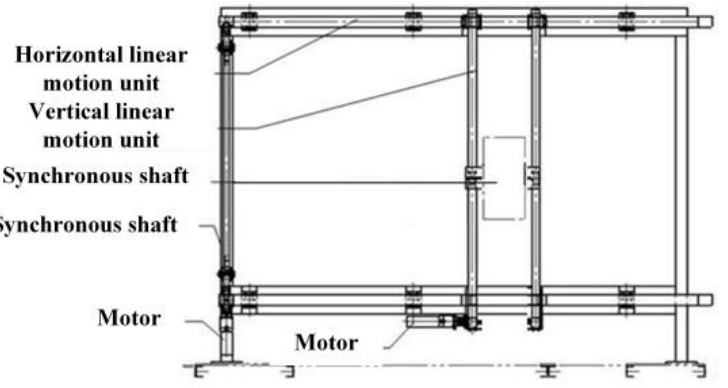
Figure 8. X-Y rectangular coordinate robot.